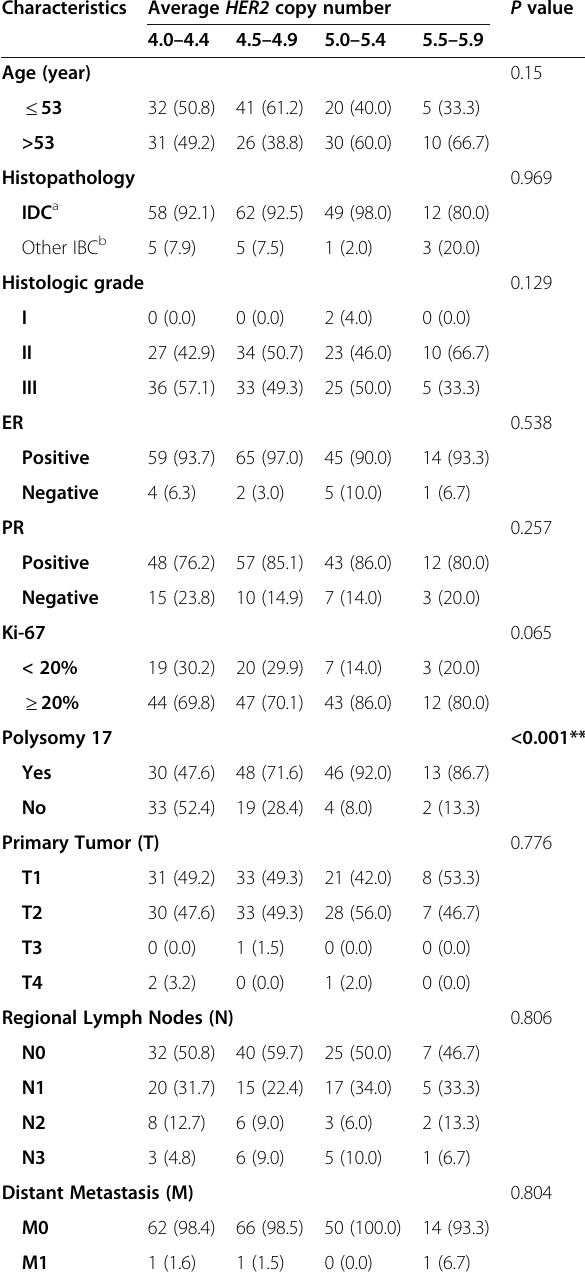
Table 2 Correlations of average HER2 copy number and major clinicopathological